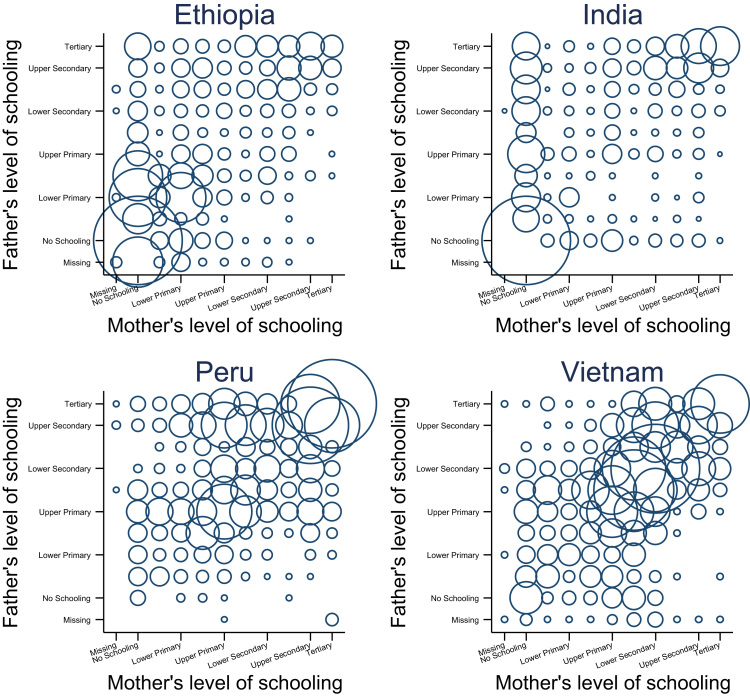
Mothers’ and Fathers’ Paired Schooling Levels. Labeled values are completed levels; intermediate levels are incomplete. The size of the circles illustrates the number of children with parents with those schooling levels.